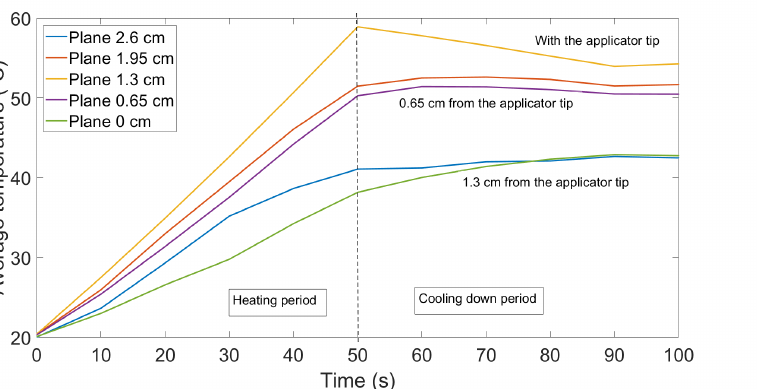
Figure 7. Change in the average temperature of the five cross-sections of the tissue along the y-axis: trial